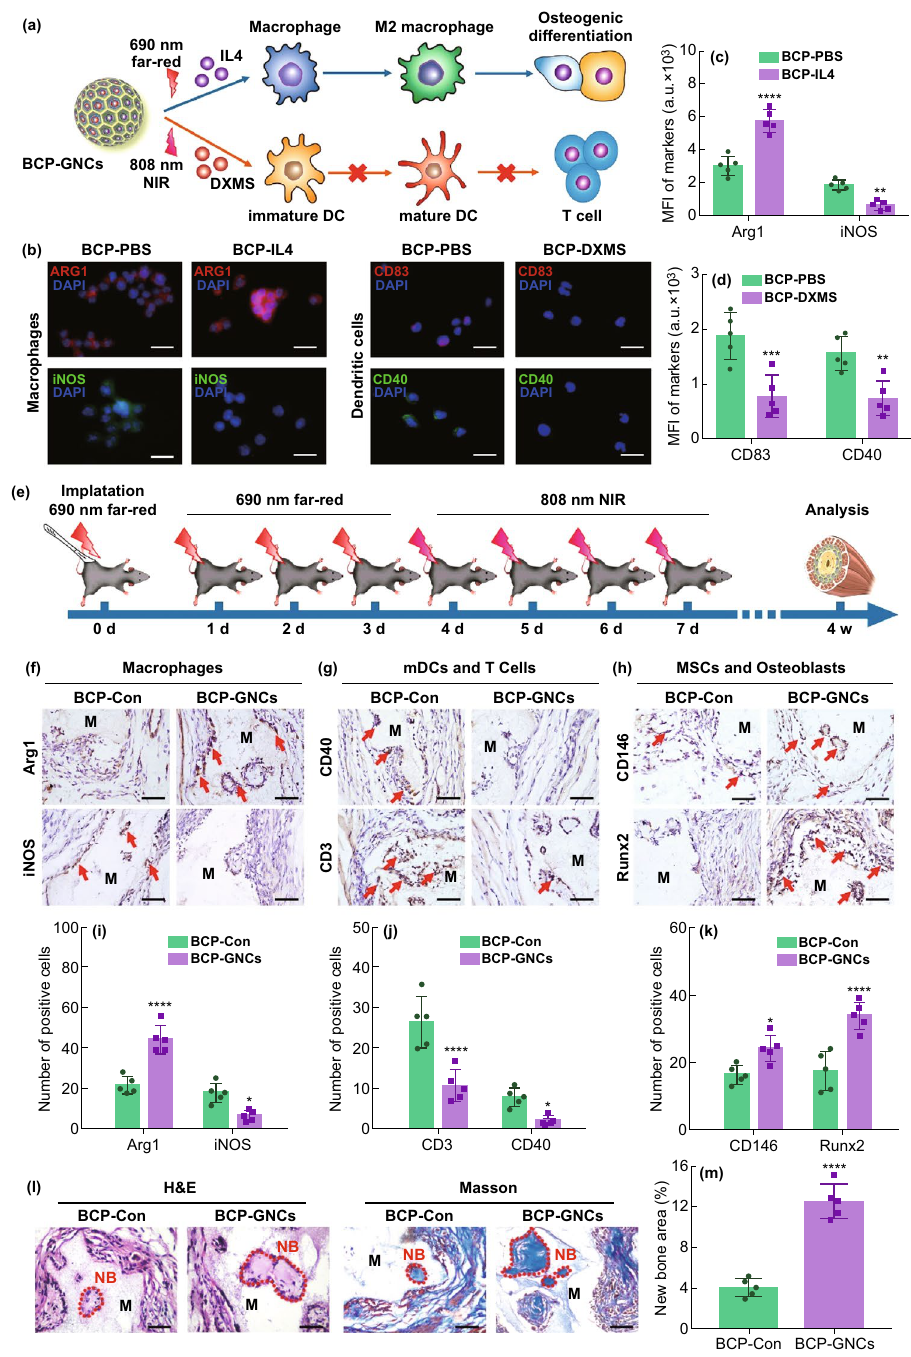
Fig. 5 a Schematic diagram of BCP-GNCs-mediated macrophage polarization and DC maturation by releasing IL-4 and DXMS. b IF staining of Arg1 (red) and iNOS (green) of macrophage, CD83 (red) and CD40 (green) of DC and nuclei (blue) after macrophages or DCs seeded on the BCP with 690 nm far-red or 808 nm NIR stimulating the release of PBS (BCP-PBS), 690 nm far-red stimulating the release of IL-4 (BCP-IL4) or 808 nm NIR stimulating the release of DXMS (BCP-DXMS) for 24 h. Scale bar = 5 μm. c, d Semiquantification of positively stained cells in ( b ). n = 5, ** P < 0.01, *** P < 0.001. e Flowchart of time course for irradiating BCP-GNC in vivo. f–h IHC staining of M1, M2 macrophages (iNOS and Arg1), mature DCs (CD40), T cells (CD3), MSCs and osteoblasts (CD146, Runx2) under the BCP-GNCs implant in vivo. Scale bar = 100 μm. Red arrow, positive cells. M, material. i – k Semiquantification of positively stained cells in (E, F, G). n = 5, * P < 0.05, ** P < 0.01, **** P < 0.0001. l H&E and Masson staining of implant area of BCP-Con and BCP-GNCs in vivo after 4 weeks (4 W) (the red dash line shows the new bone formation area; NB, new bone; M, material). m Semiquantification of new bone area in ( k ). n = 5, **** P <